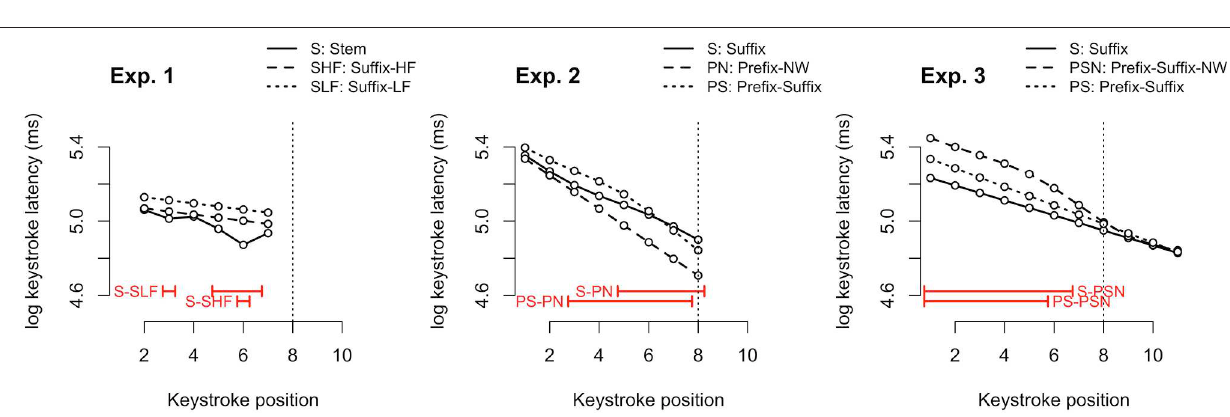
FIGURE 8 | Estimates from the GAMM models fitting the keystroke trajectories (excluding the first keystroke) aligned to the onset of the stem for all conditions ([stem, stem + suffix low frequency; stem + suffix high frequency]; [stem + suffix; prefix + stem (NW); prefix + stem + suffix]; [stem + suffix; prefix + stem + suffix (NW); prefix + stem + suffix] in Experiments 1, 2, and 3 respectively. The onset of the stem is labeled as 1. Positions with significant latency differences are indicated in red. The vertical dashed line indicates the median onset of the suffixes, which are only included in the analysis of Experiment